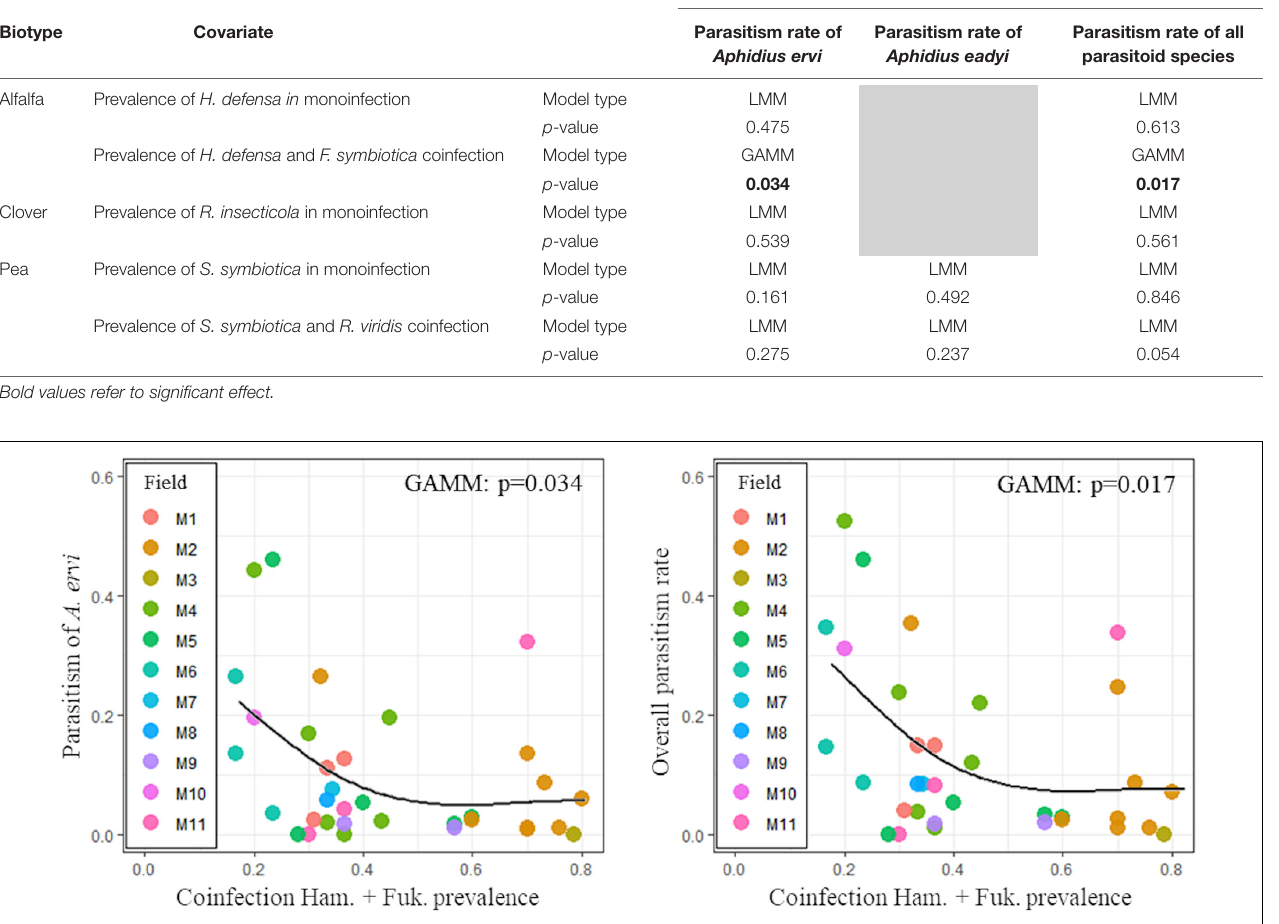
FIGURE 6 | Relationship between Hamiltonella defensa / Fukatsuia symbiotica coinfection and parasitism rate (assessed for the dominant parasitoid species, Aphidius ervi , and for all parasitoids) in pea aphids from alfalfa fields. ID refers to the alfalfa field. Solid line represents the predicted values from the fitted generalized additive mixed